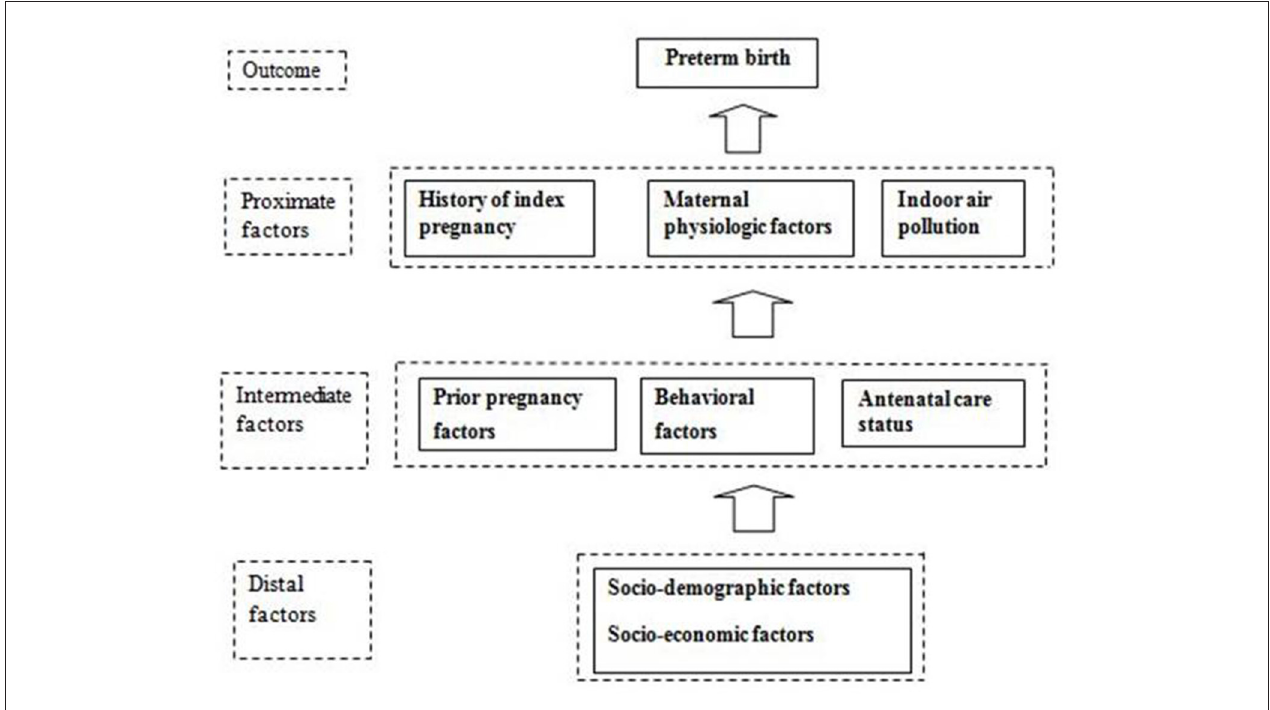
FIGURE 1 | Conceptual framework of the study.